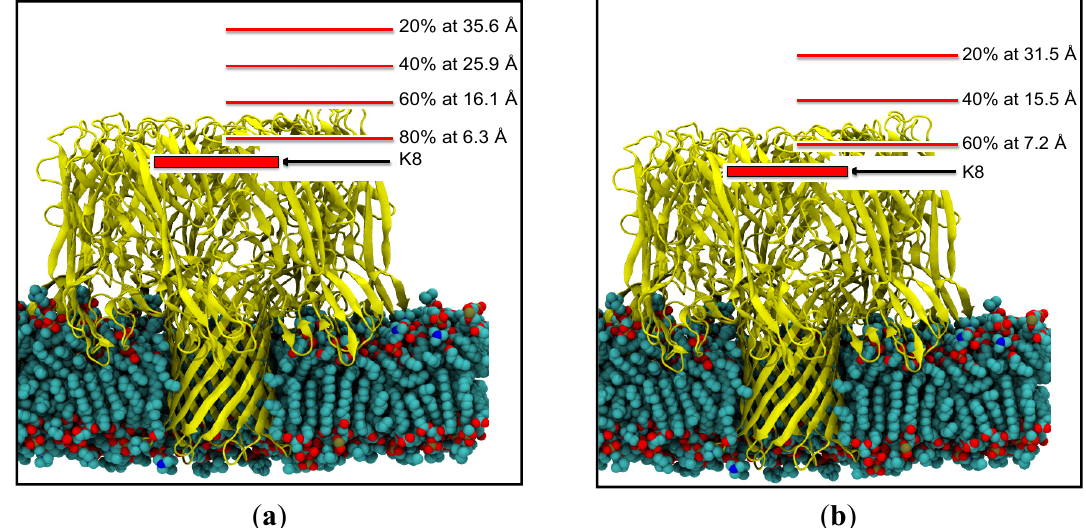
Figure 4. The probabilities of entry for given release points relative to the ring of K8 residues for ( a ) the phosphate down orientation and ( b ) the phosphate up